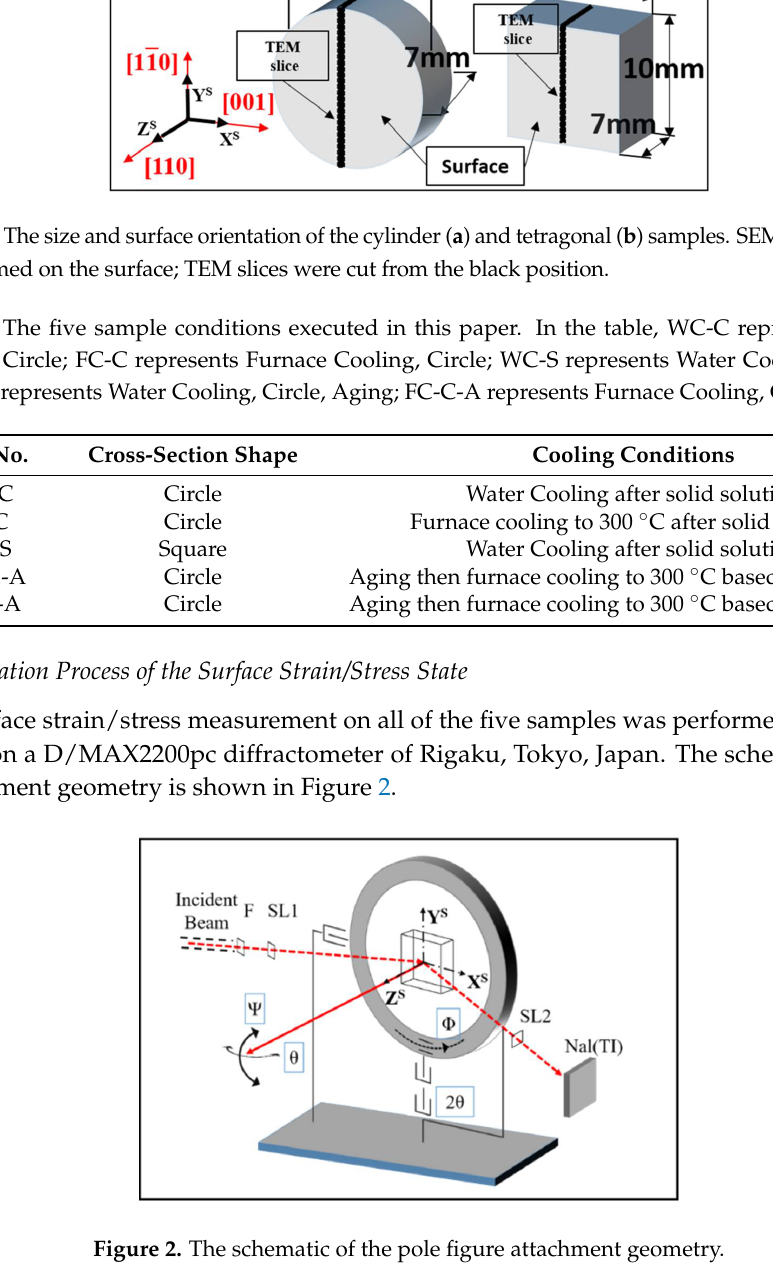
Figure 2. The schematic of the pole figure attachment geometry.